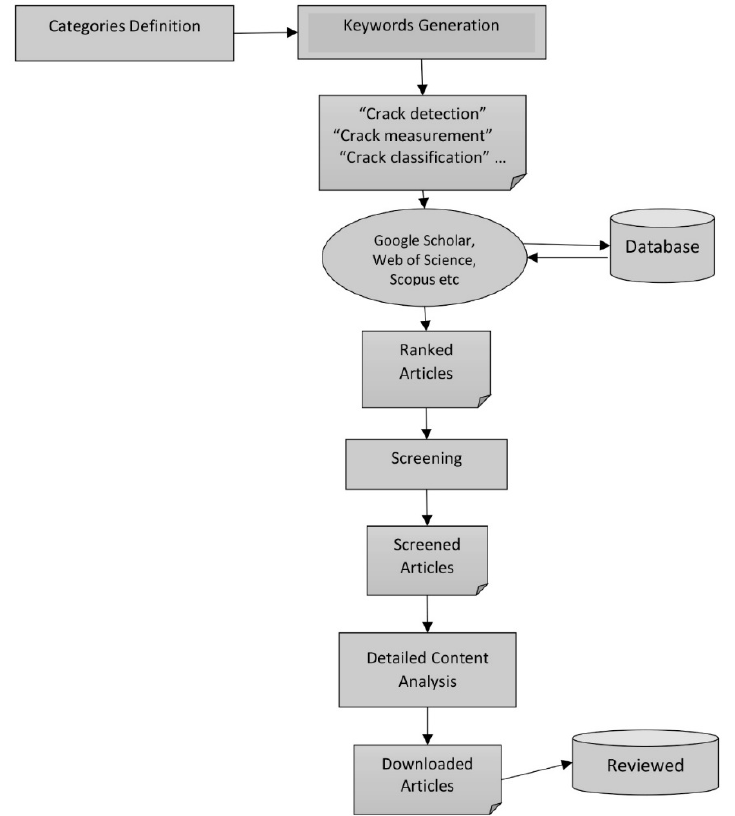
Figure 3. Methodology of article screening.